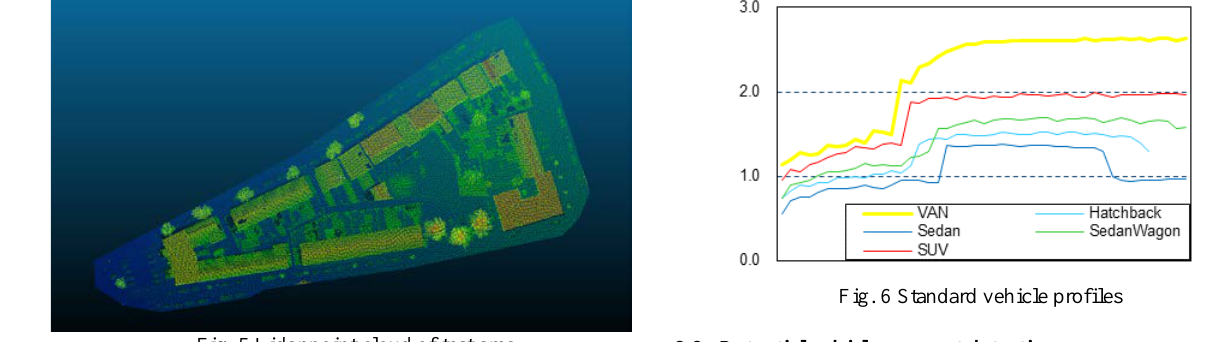
Fig. 5 Lidar point cloud of test area